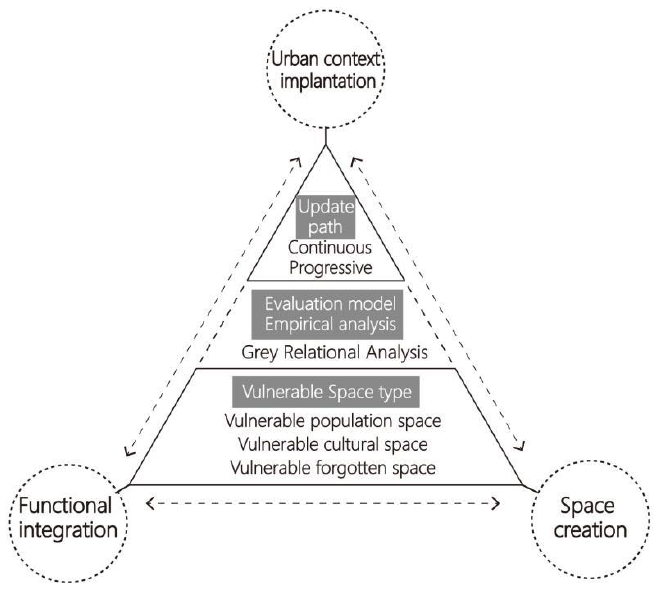
Figure 1. Cognitive framework of urban vulnerable spaces.